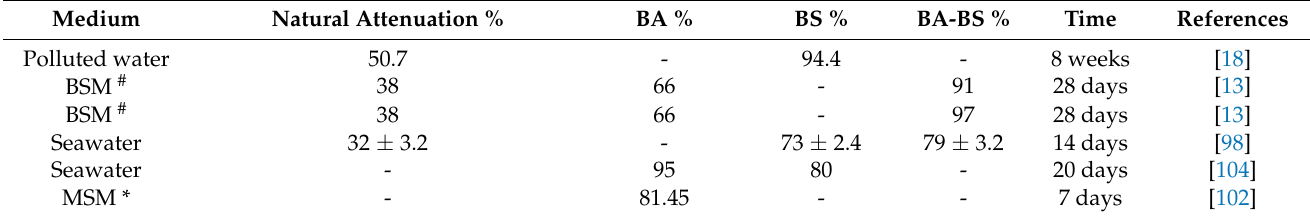
Table 7. Comparison of different bioremediation outcomes on petroleum